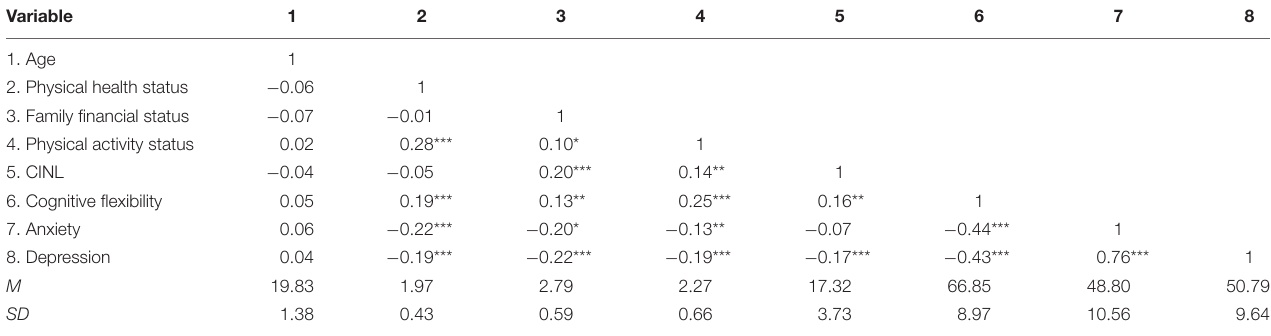
TABLE 5 | Descriptive statistics and correlation matrix for each variable ( N = 416).